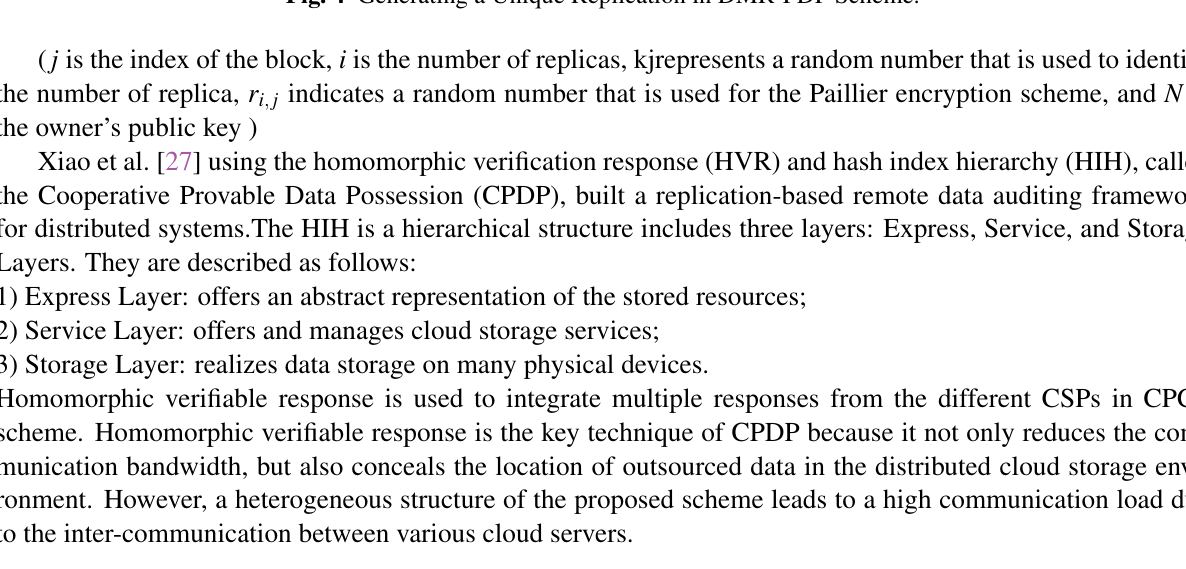
Fig. 4 Generating a Unique Replication in DMR-PDP